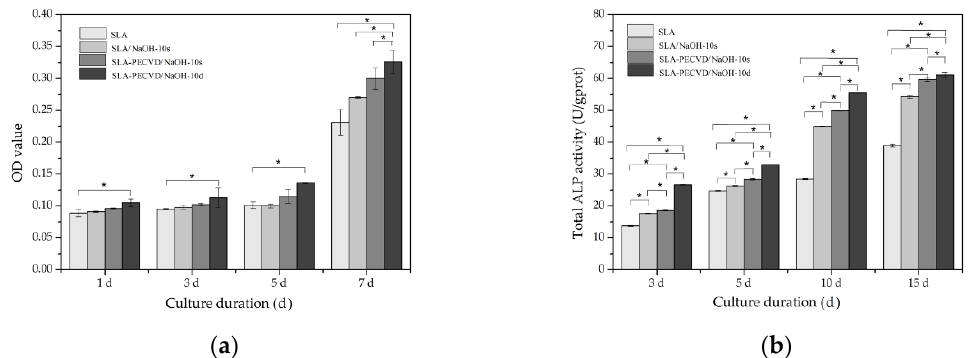
Figure 9. The MTT: ( a ) results and total alkaline phosphatase (ALP) and ( b ) activity of four groups. * p < 0.05, indicating a statistically significant difference among the groups.